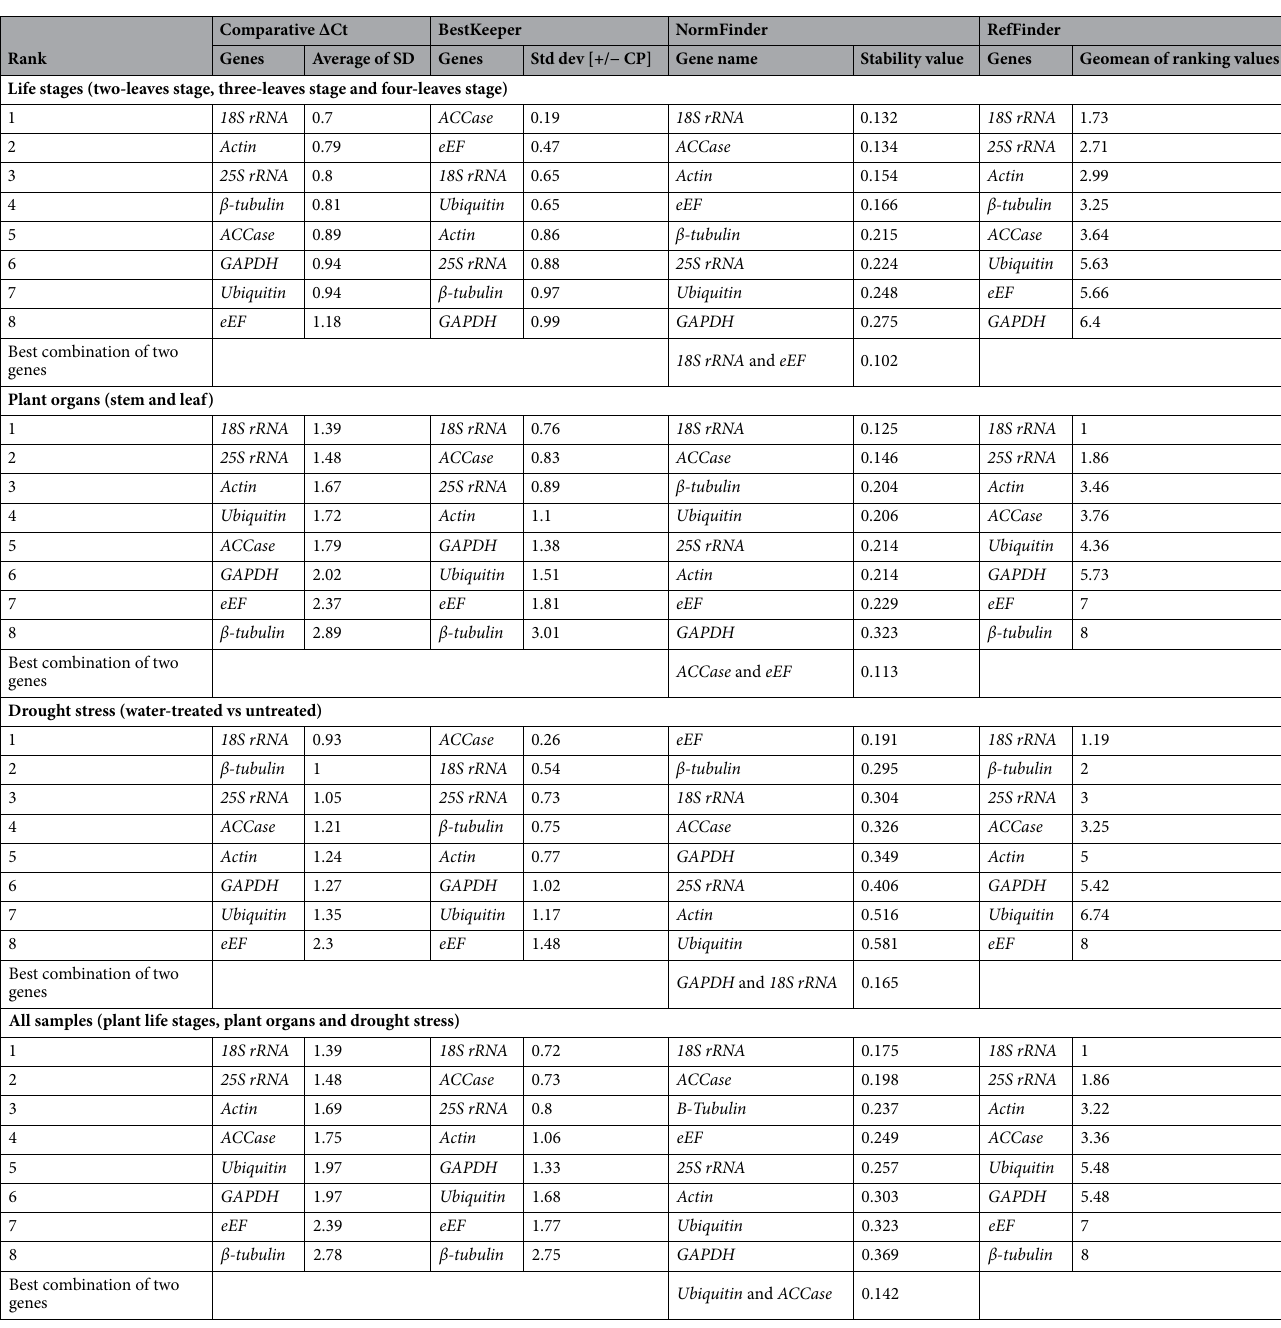
Table 2. Expression stability of candidate genes analysed by ΔCt, BestKeeper, NormFinder and RefFinder. RefFinder compares the results evaluated by four different programs (comparative ΔCt method, geNorm, BestKeeper and NormFinder) and based on the geomean of ranking values, provides a comprehensive ranking. St. dev.: standard deviation; St. dev [+ /− CP]: standard deviation of crossing point (CP) values, eEF: eukaryotic elongation factor, ACCase: Acetyl-CoA